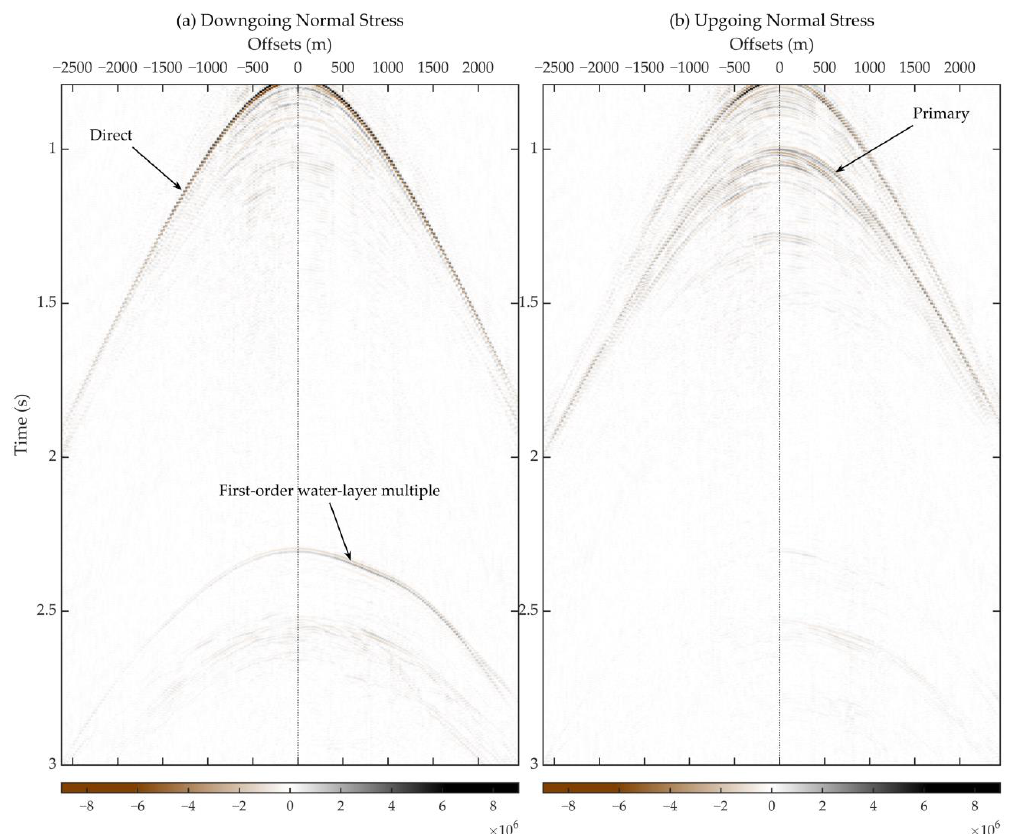
Figure 10. The ( a ) downgoing and ( b ) upgoing normal stress separated just below the seafloor. The colormaps of both sides have been unified. The direct wave and the first-order water-layer multiple in downgoing stress and primary events in upgoing stress are indicated by the black arrows.